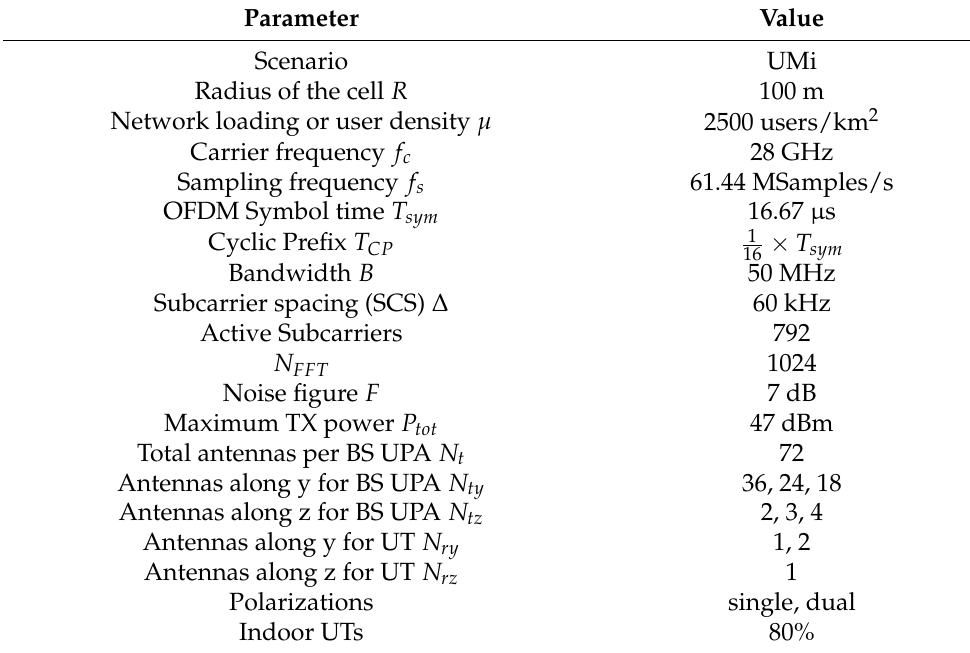
Table 1. Simulation